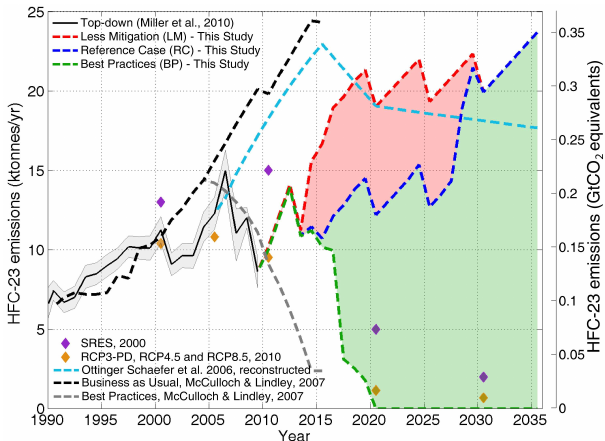
Fig. 2. HFC-23 global emission projections for the three scenar- ios presented in this paper, with the top-down emission estimates of Miller et al. (2010) as the starting point for projection. Shown for comparison are the SRES and RCP projections, and a reconstruc- tion of the Ottinger Schaefer et al. (2006) projection based on the assumptions (Table S2) described in their paper. The Less Mitiga- tion (LM) scenario depicts emissions if renewals of CDM projects are not approved. Implementation of additional incineration, a Best Practices (BP) scenario, could bring emissions to virtually zero af- ter an initial startup lag. The RCP scenario most closely resembles our BP